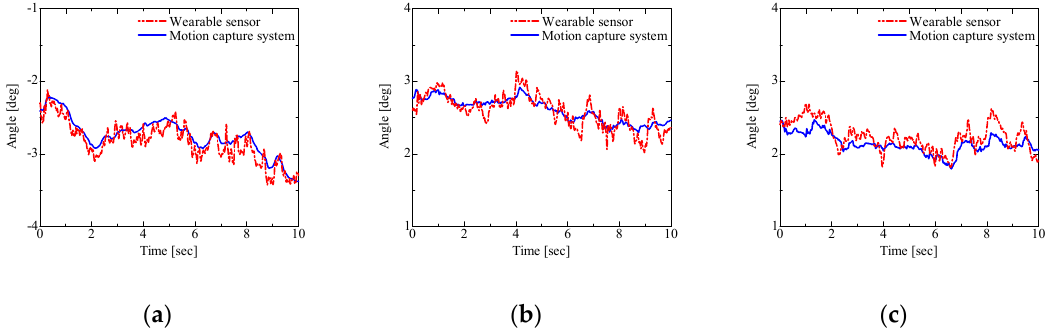
Figure 5. Results for joint angle estimated using the wearable sensor and obtained by the motion capture system; ( a ) Ankle joint angle; ( b ) Knee joint angle; ( c ) Hip joint angle.